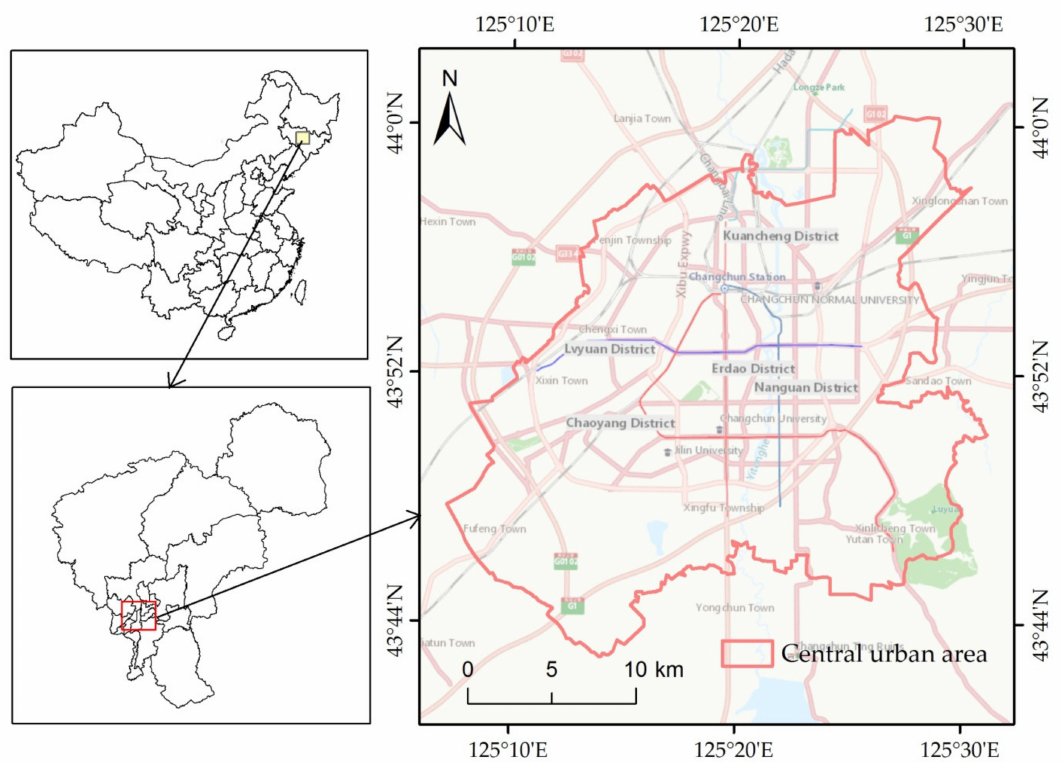
Figure 1. Location of the study area. The base map is from ChinaOnlineCommunityENG